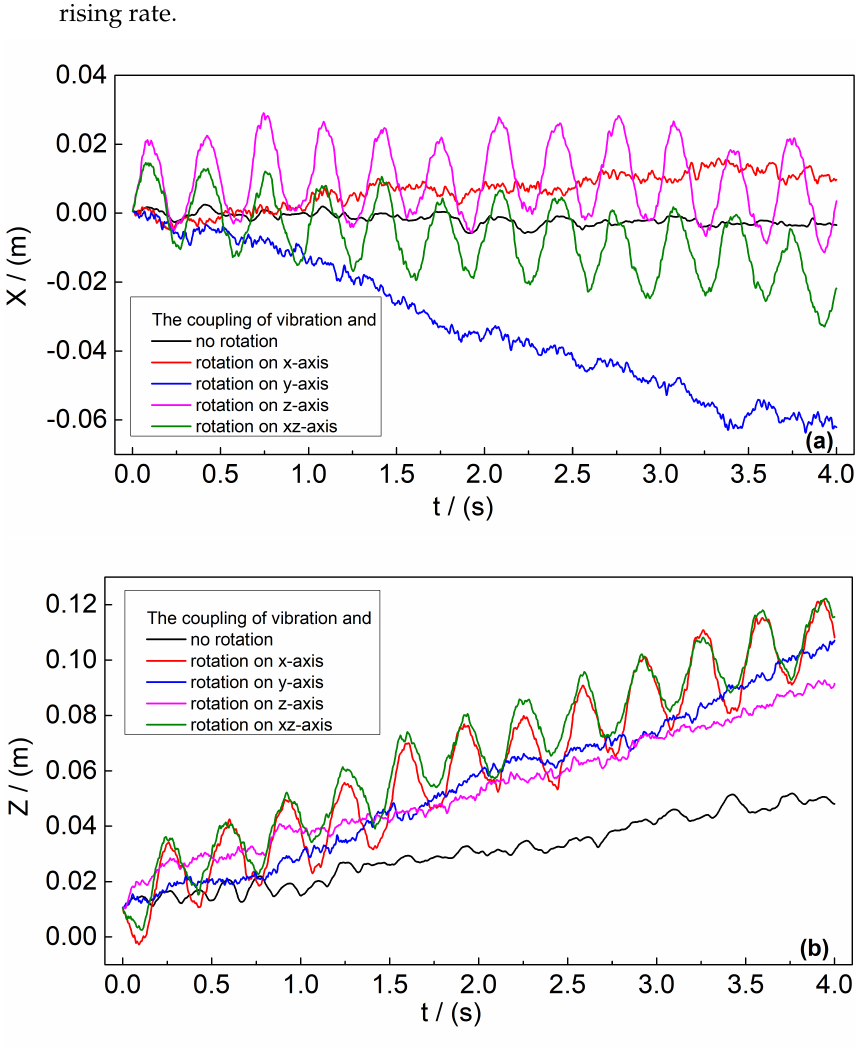
Figure 2. The dynamics of the SO with the coupling of vibration and rotation around different axes. ( a ) The movement of the SO in the x direction. ( b ) The movement of the SO in the z